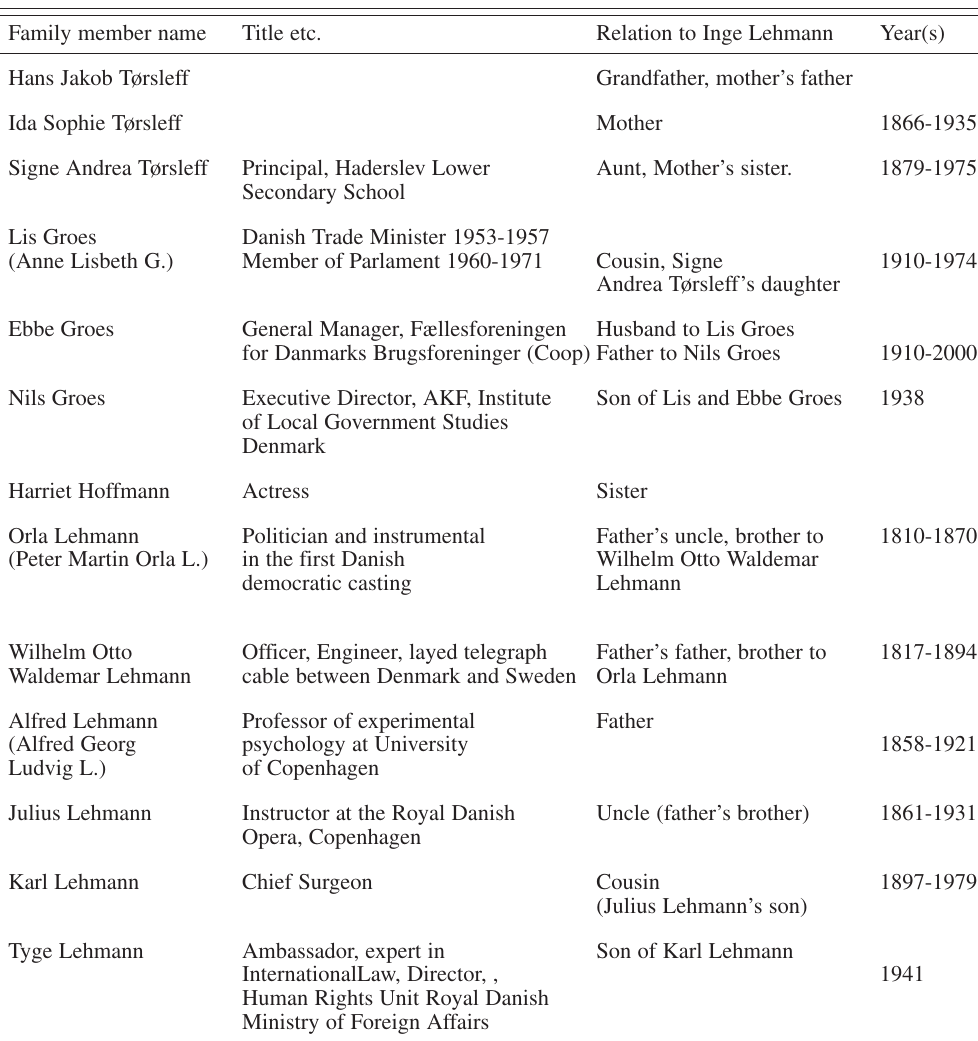
Table I. Some of Inge Lehmann’s closest family. Family member